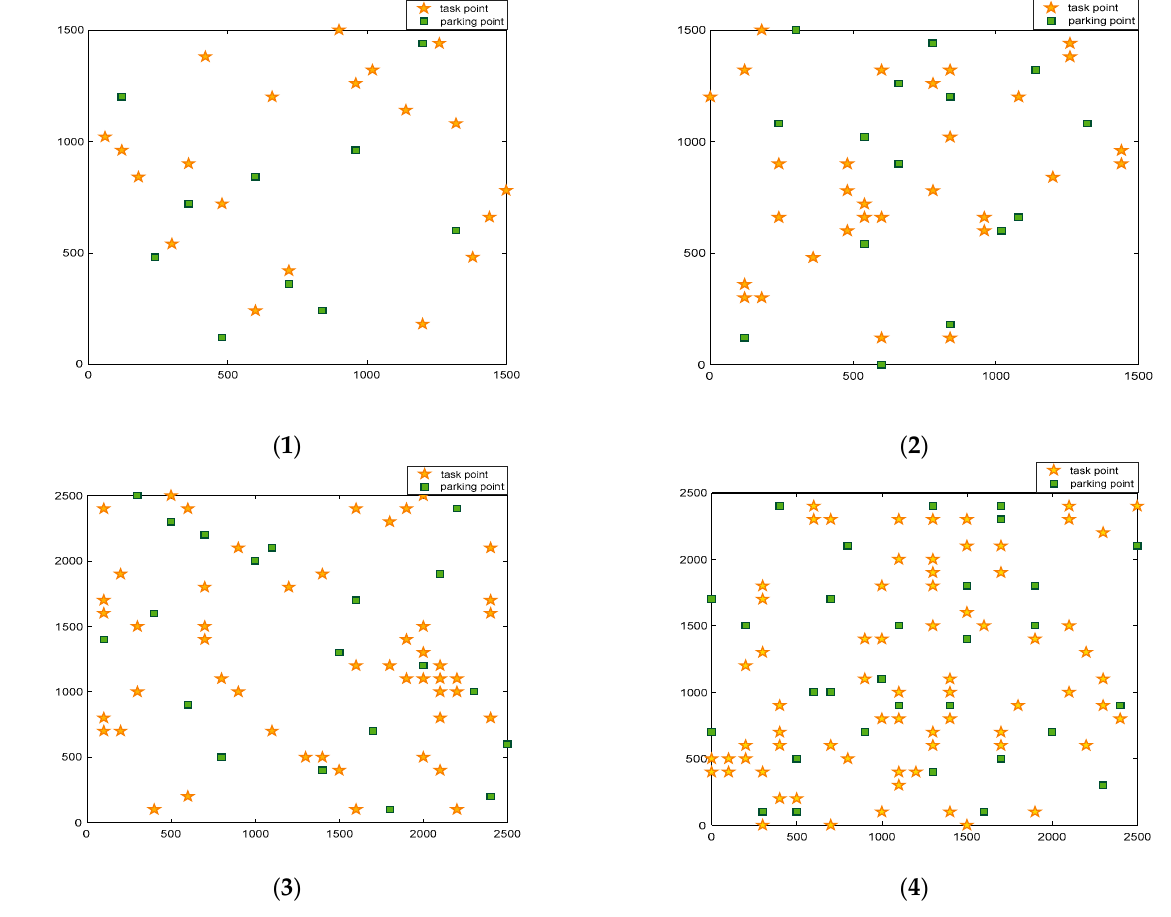
Figure 13. Distribution of the task and parking points in the four test instances. ( 1 ) instance of 20 task points and 10 parking points; ( 2 ) instance of 30 task points and 15 parking points; ( 3 ) instance of 50 task points and 20 parking points; ( 4 ) instance of 70 task points and 30 parking points. Energies 2020 , 13 , x FOR PEER REVIEW